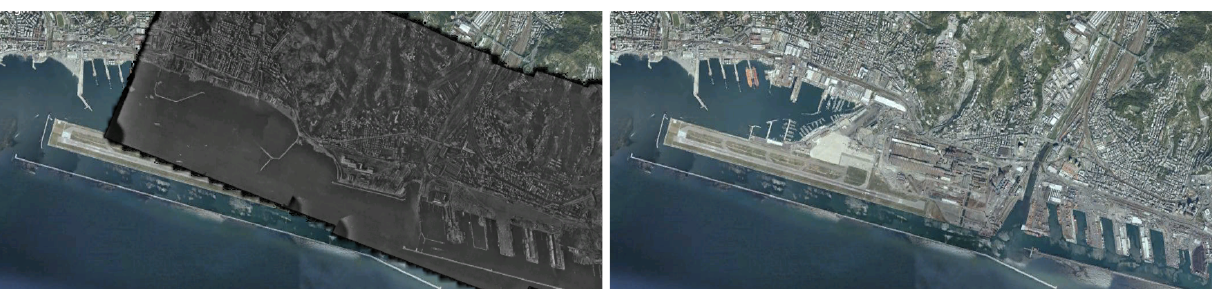
Figure 16. Left : The bay of Genoa in 1943 before the construction of the airport, which was a popular beach for the locals. Right : The bay as it is now, taken up by the Cristoforo Colombo airport ( c (cid:13) MiBAC-ICCD, Aerofototeca Nazionale, fondo RAF. c (cid:13) 2010